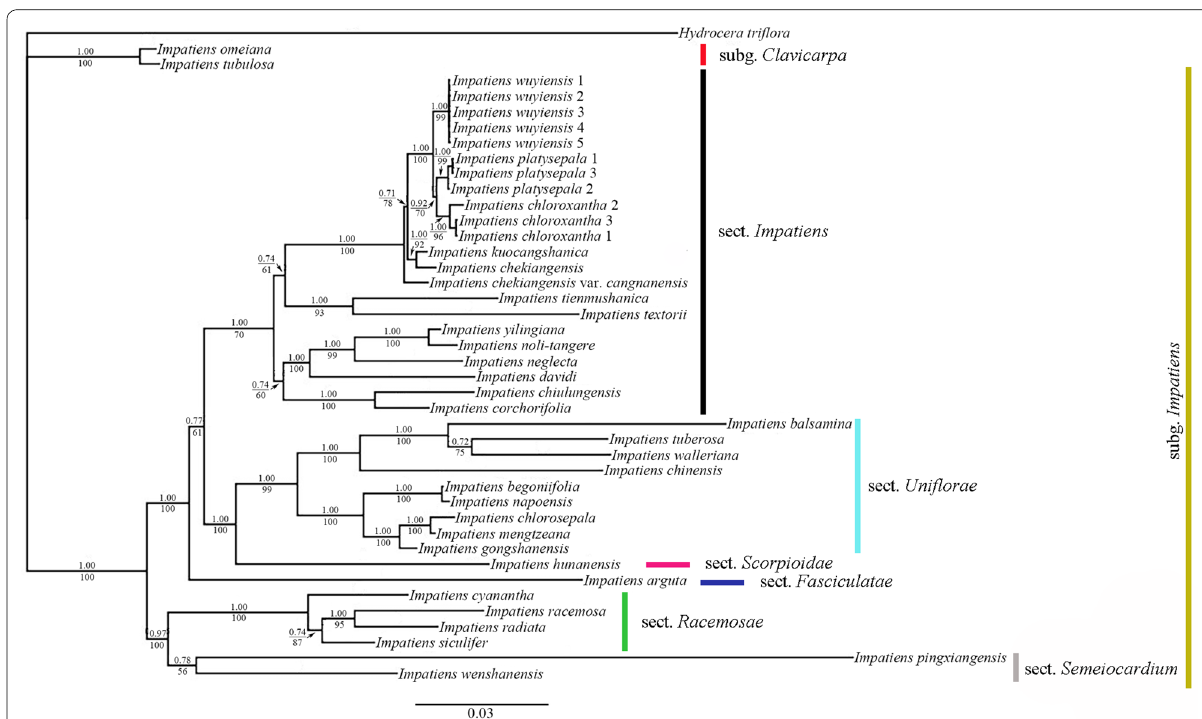
Fig. 3 Majority consensus tree inferred from Bayesian analysis based on the nrDNA ITS and cpDNA atp B‑ rbc L and trn L‑F data. Values above the branches are Bayesian posterior probabilities (PP 50%), and those below the branches are maximum parsimony bootstrap supports (BS ≥